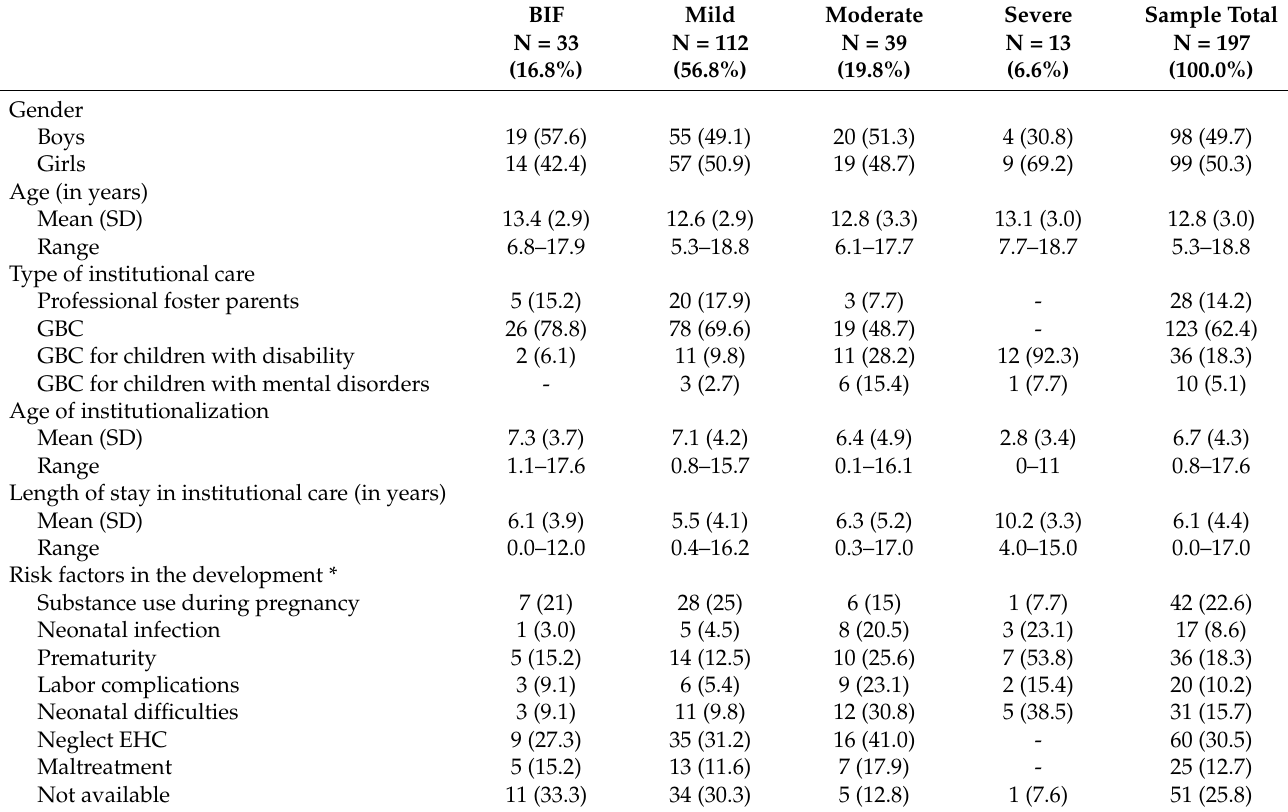
Table 1. Profile of the study